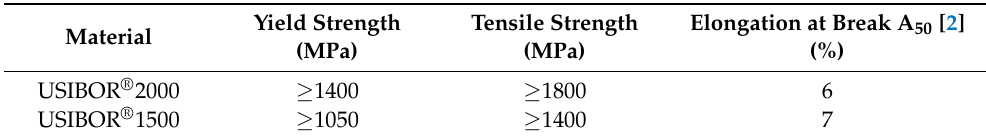
Table 2. Mechanical properties for USIBOR ® 2000 and USIBOR ® 1500. Yield Strength Tensile Strength Material (MPa) (MPa) (%) USIBOR ®